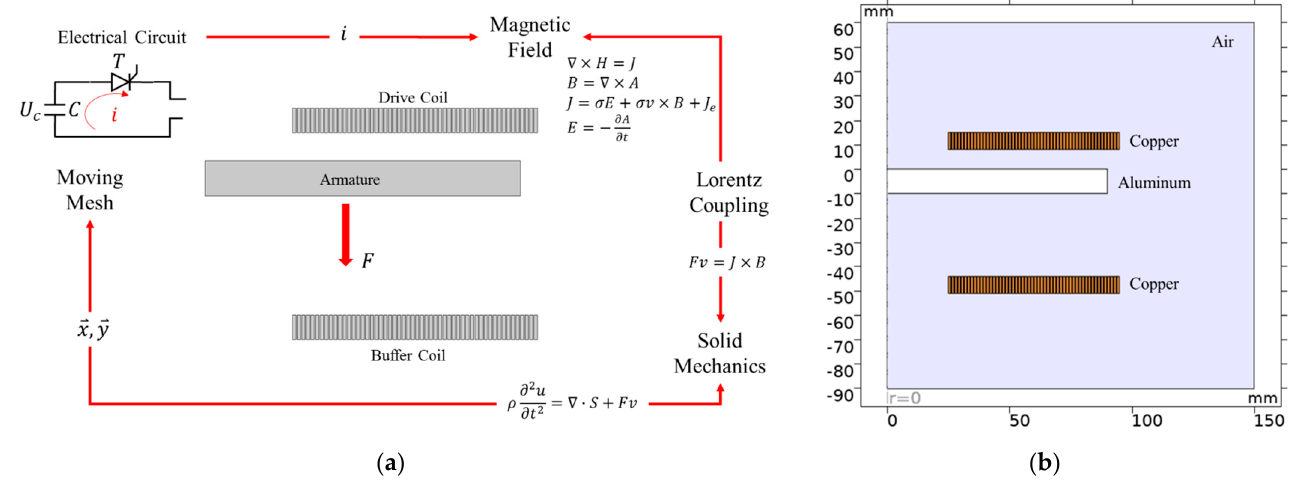
Figure A3. FEM geometry showing the drive coil, armature, and buffer coil. ( a ) FEM coupling; ( b ) 2D, axial-symmetric geometry configuration and